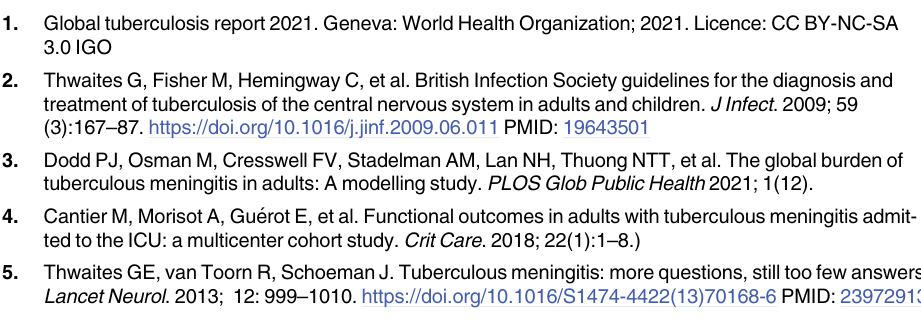
S1 Table. PRISMA checklist for systematic review and meta-analysis. S2 Table. Quality assessment of included studies. S3 Table. Raw data for the